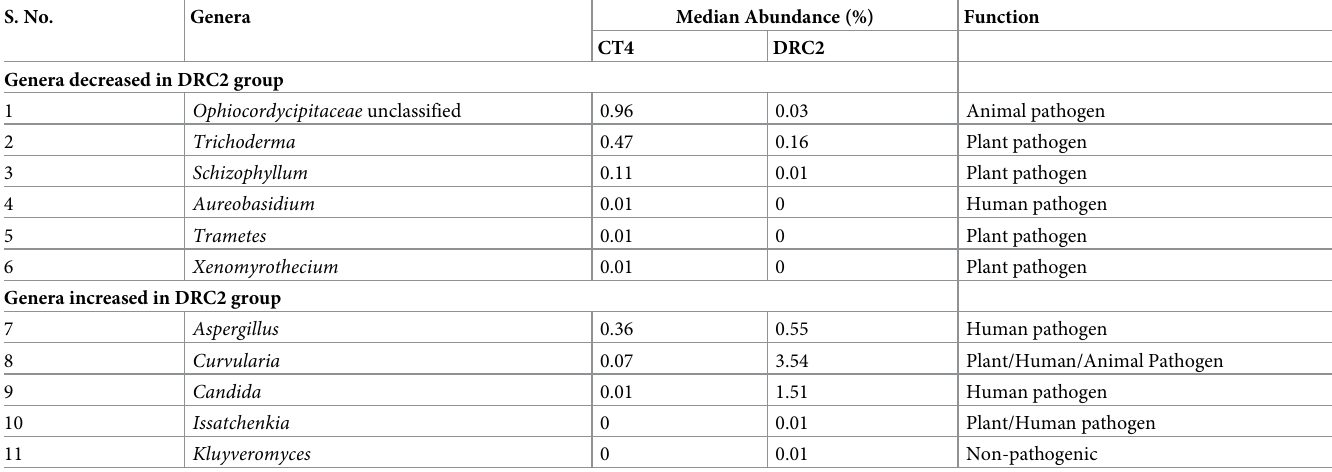
Table 6. Significant differences in the median abundance of discriminatory genera ( > 0.01% in any one of the groups; P-value � 0.05) in gut mycobiomes from con- trol (CT4, n = 6) and diabetic rats showing retinal changes (DRC2, n = 5). S.